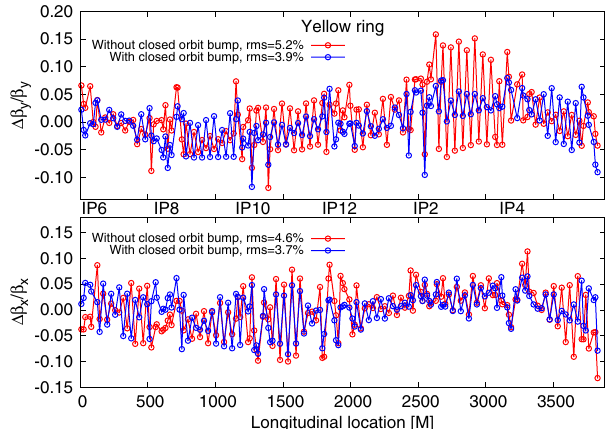
FIG. 12. Horizontal (bottom) and vertical (top) residual beta- beat with and without the horizontal closed orbit bump displayed in Fig. 11 for the Yellow ring. The peak beta-beat was reduced to 7% for both planes with the closed orbit